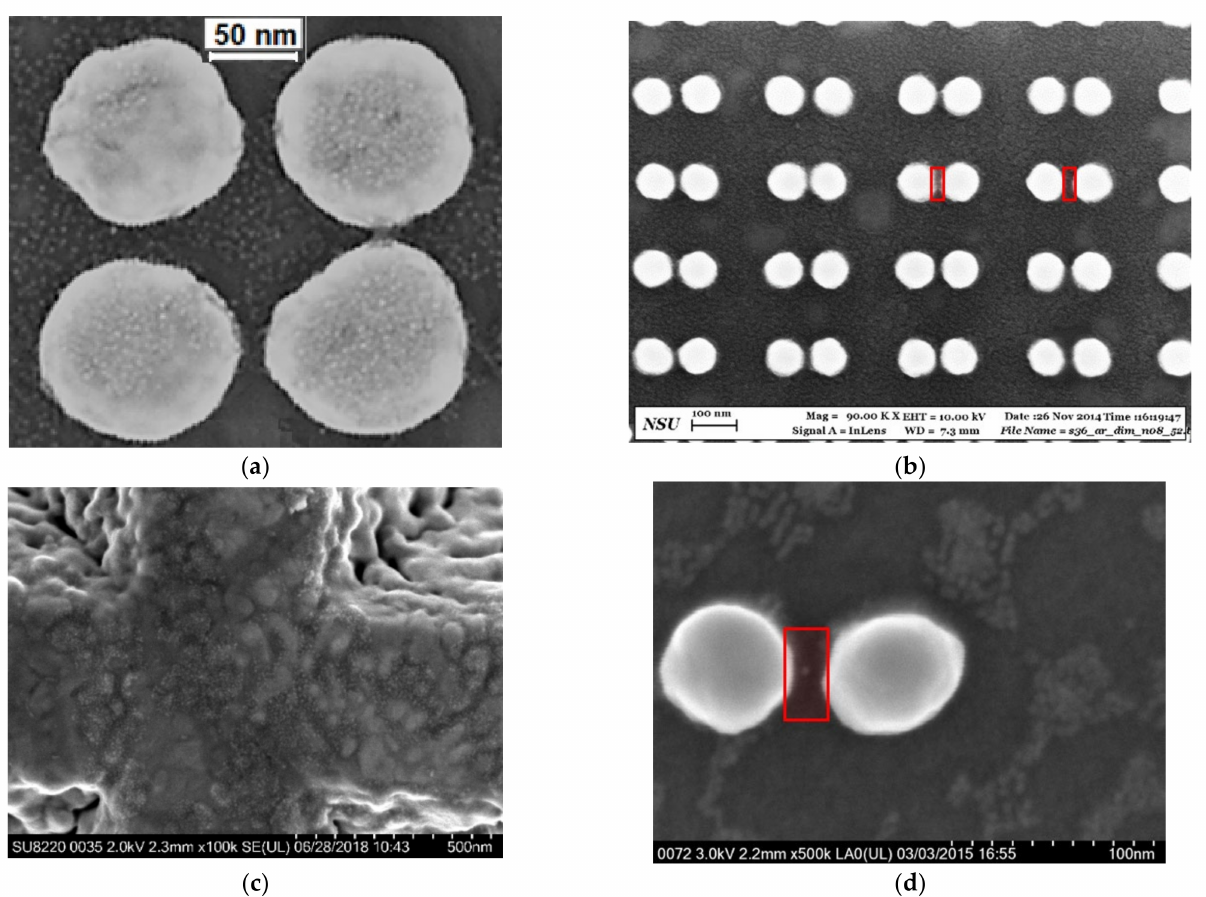
Figure 6. SEM images of a fragment of the Au nanodisk array ( a ), dimers ( b ), and Klarite substrate ( c ) covered homogeneously with CdSe NCs (tiny bright spots). ( d ) Typical SEM image of single nanodimer covered by a submonolayer of CdSe NCs. The red semitransparent rectangular areas indicate regions with CdSe NCs contributing to SERS. The images are adapted from [43]. Copyright 2016,